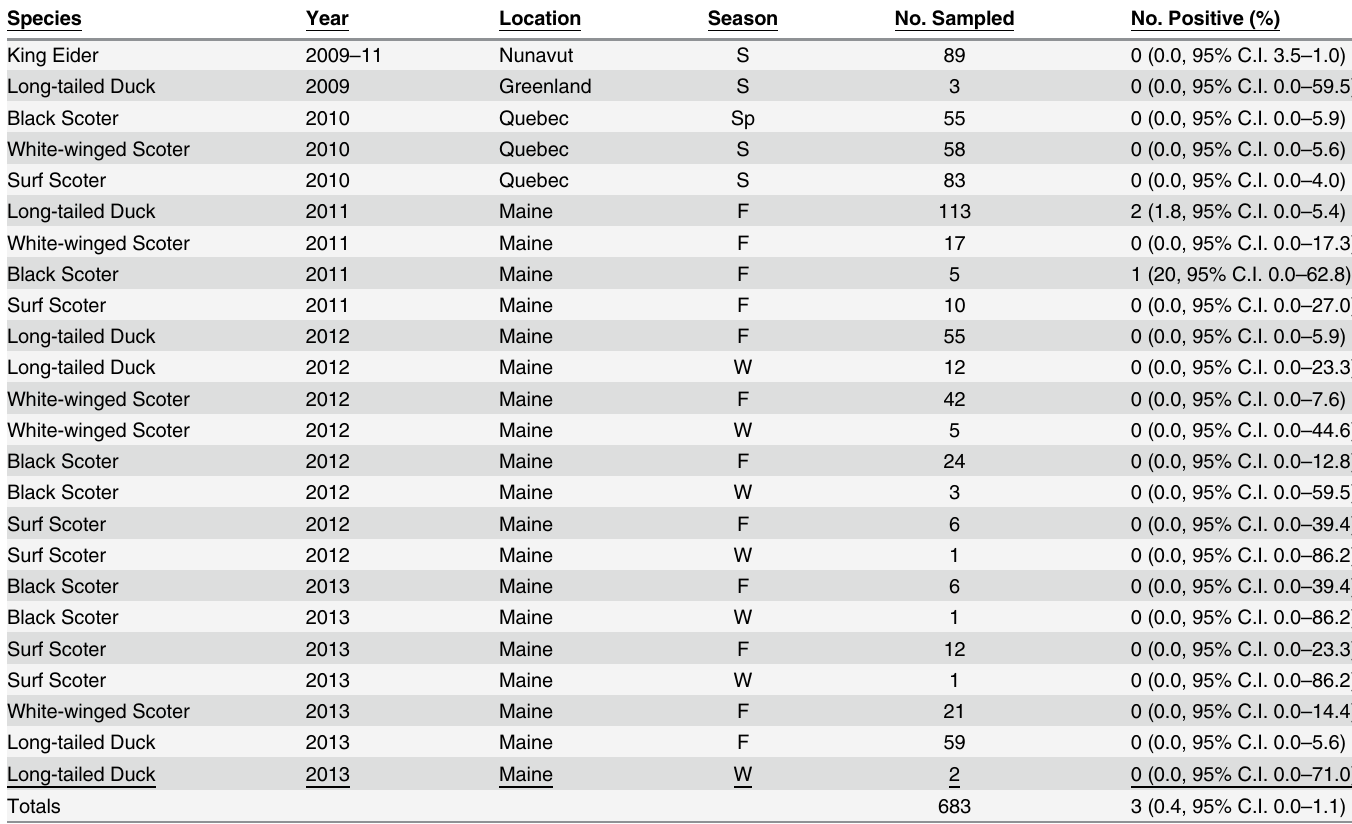
Table 5. RT-PCR detection of avian influenza virus RNA in North Atlantic sea ducks, other than common